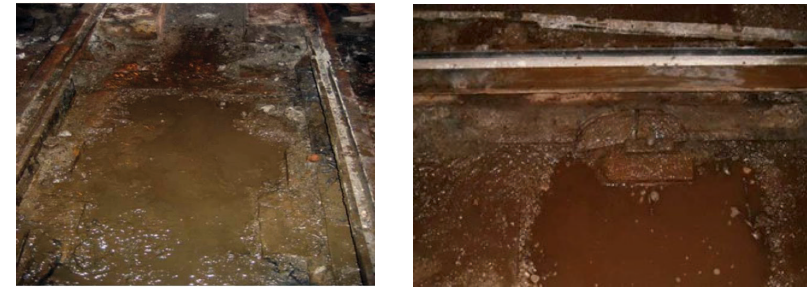
Figure 3. Condition of the closed track formation during the most part of